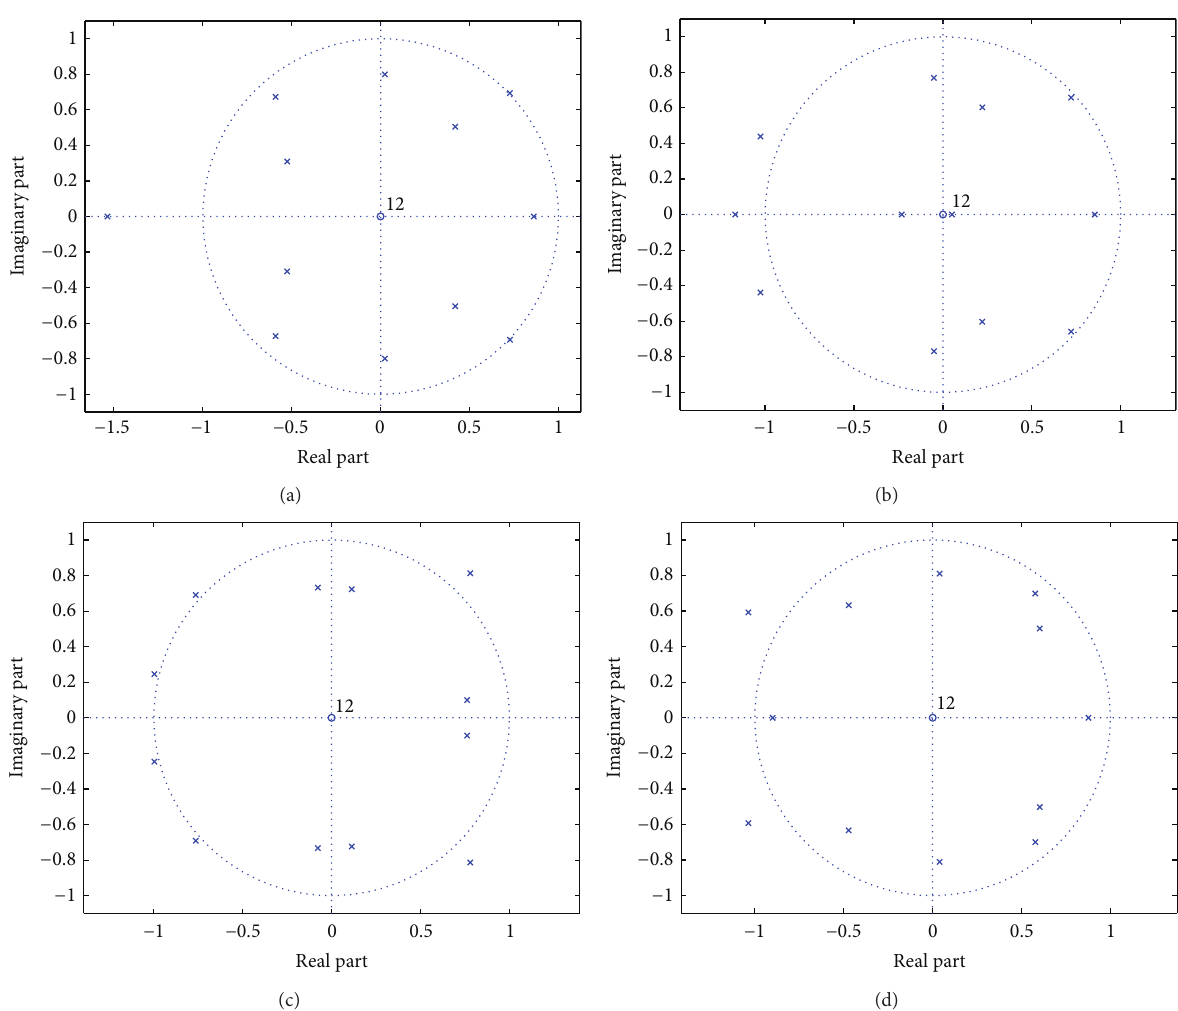
Figure 11: Pole zero plots of the vocal tract for vowel /a/ at times 7:00 AM day 1 (upper left side) 10:00 PM day 2 (upper right side), 3:00 PM day 1 (lower left side), and 9:00 PM day 2 (upper right side).